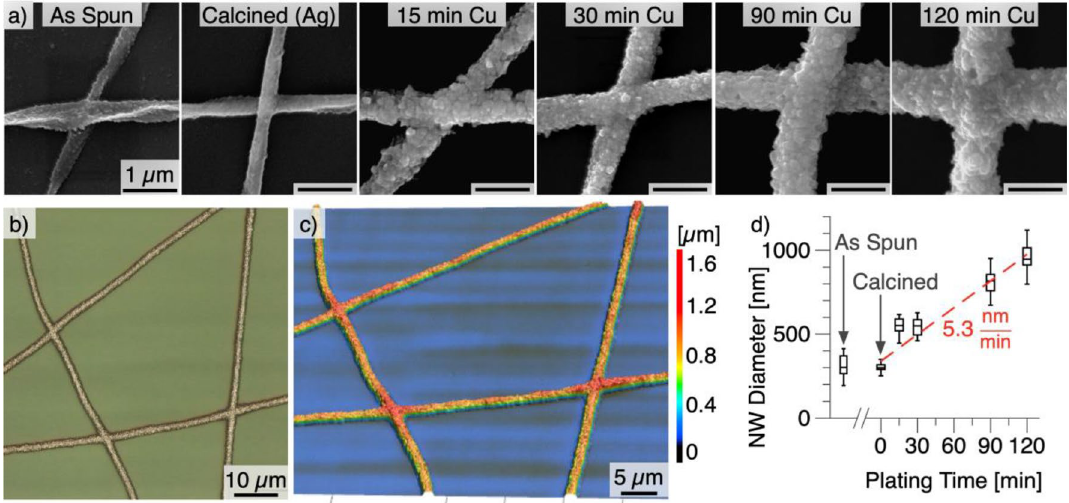
Figure 2. ( a ) SEM images showing nanowire junctions after electrospinning, calcination, and electroless copper plating for 15–120 min. ( b ) Optical image of a sample after copper plating shows three uniformly fused junctions. ( c ) Three-dimensional height map of nanowires after copper plating. ( d ) Plot of nanowire diameter versus plating time. The red line is a linear regression of the